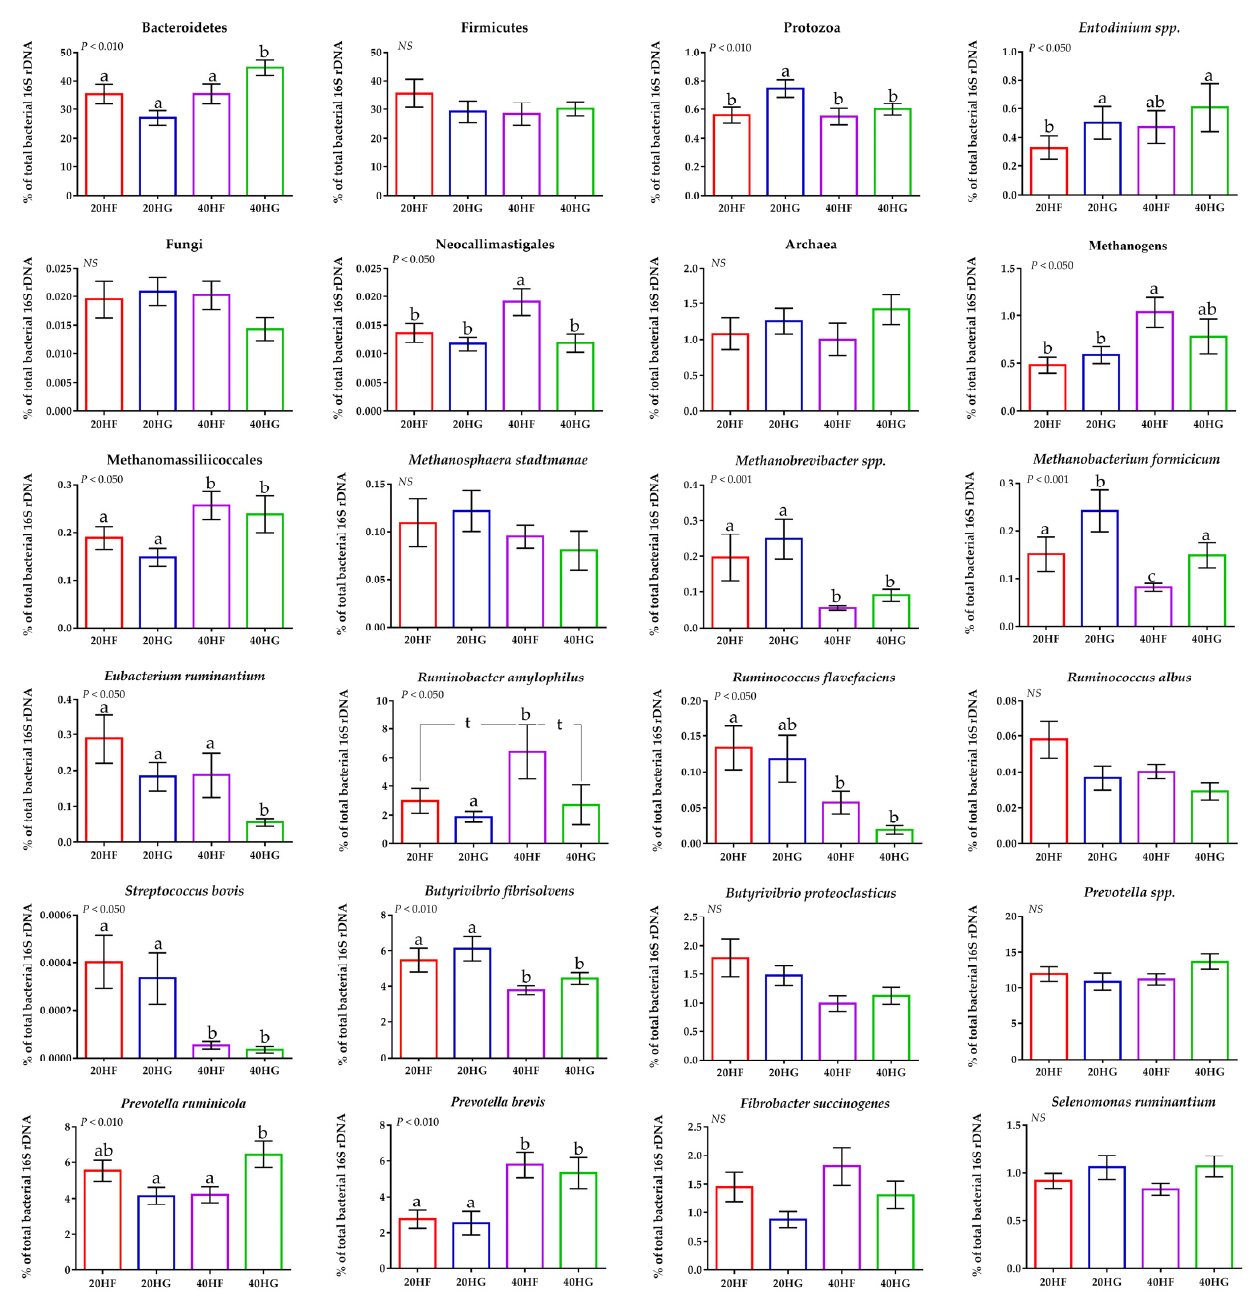
Figure 3. Average changes of target microorganisms in the rumen liquid of goats fed diets (20HF, 20HG, 40HF, and 40HG) with different levels of Schizochytrium spp . (20 g and 40 g/goat/day) and two different forage to concentrate ratios (60:40 and 40:60) throughout the experimental period (21 and 42 experimental days) illustrated in column bars (±Standard Error of Means) as a proportion of total rumen bacterial 16S rDNA. Bars with different superscript (a, b, c) between dietary treatments differ significantly ( p ≤ 0.05) while t is referred to p -value < 0.10, according to the Analysis of Variance (ANOVA) using a general linear model for repeated measures and Post hoc analysis was performed when appropriate using Tukey’s multiple range test. Additional statistics investigating the interaction of microalgae level, forage to concentrate ratio, and the sampling time effect are available in Tables S4 and S5.